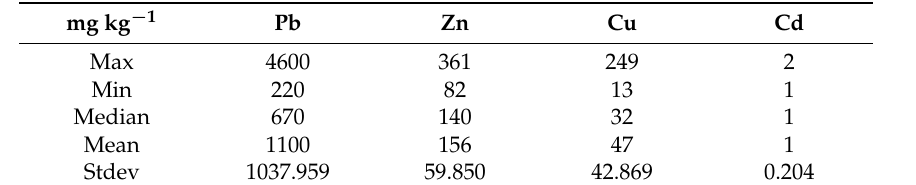
Table 1. Descriptive statistics of heavy metal concentrations in the soil of the contaminated area in Bow Street, UK, based on 85 samples. Max, Min, Median, Mean and Stdev are maximum, minimum, median, mean and standard deviation, respectively. The minimum detection limits of the atomic